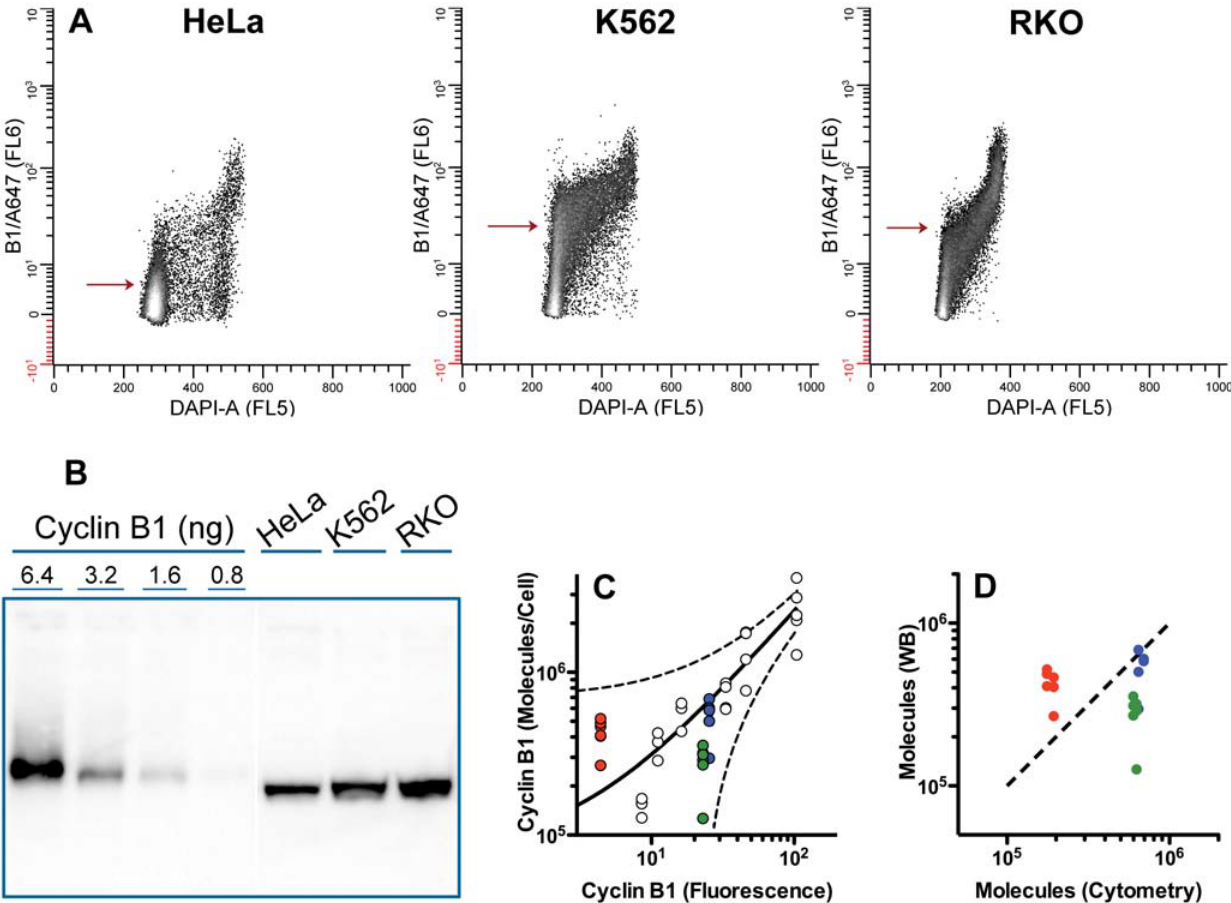
Figure 7. Test cell lines. Samples of HeLa, K562, and RKO were fixed with methanol then stained for cyclin B1 with GNS1-AlexaFluor 647 (A647) and DNA (DAPI). Part of the sample was also lysed and subject to Western blot analysis in the same manner as the standard lysates described in Figure 5. ( A ) cytometry data are displayed as in Figure 5. Arrows indicate the mean cyclin B1 related fluorescence. ( B ) Western blot prepared as in Figure 5. The lanes for the test cell lines were not loaded with equal cell numbers; loading was adjusted to obtain bands with intensities within the range of the cyclin B1 standards. Protein concentration was equalized with trypsin inhibitor. ( C ) co-plot of the standard curve and the test samples using the measured values for cyclin B1 molecules obtained by Western analysis for the test samples. HeLa=red circles; K562=blue circles; RKO=green circles. The 95% prediction band for the standard curve is plotted (dashed lines). ( D ) Molecules were determined by Western blotting (Y axis) and by cytometry using the standard curve (X axis). The dashed line is a one-to-one correlation. Color coding is as in